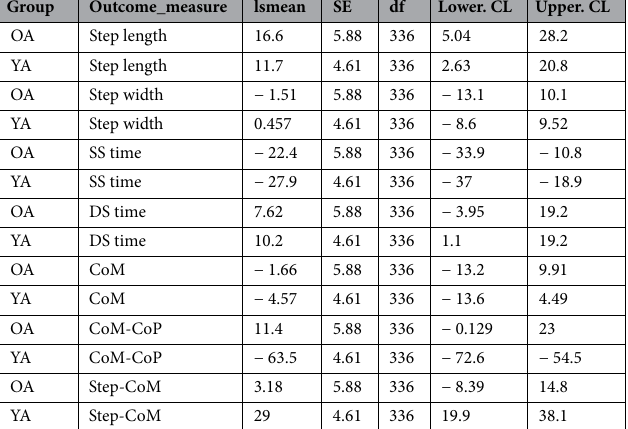
Table 5. Split Magnitude of Plateau posthoc comparisons: estimated 95% confidence intervals for % (cid:31) magnitude of the plateau for the split condition [lmer Eq. (2)].